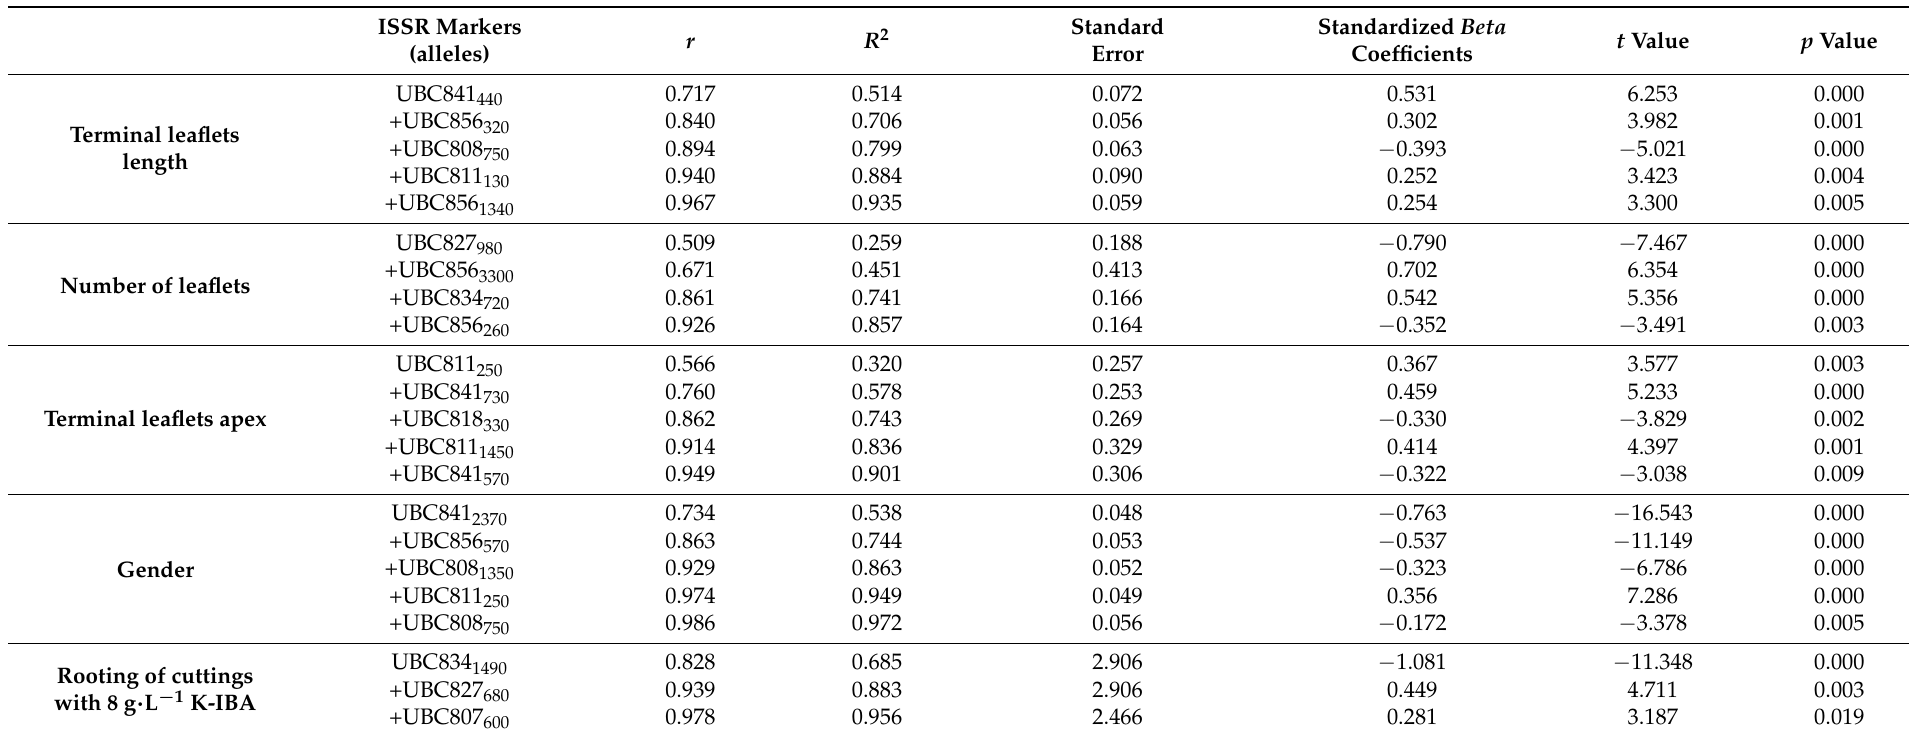
Table 5. Association of ISSR markers and various traits, gender and rooting of cuttings of P. lentiscus var. Chia genotypes as revealed by stepwise multiple regression analysis (MRA) and